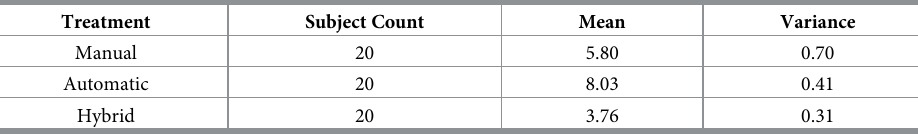
Table 3. Data summary—Group